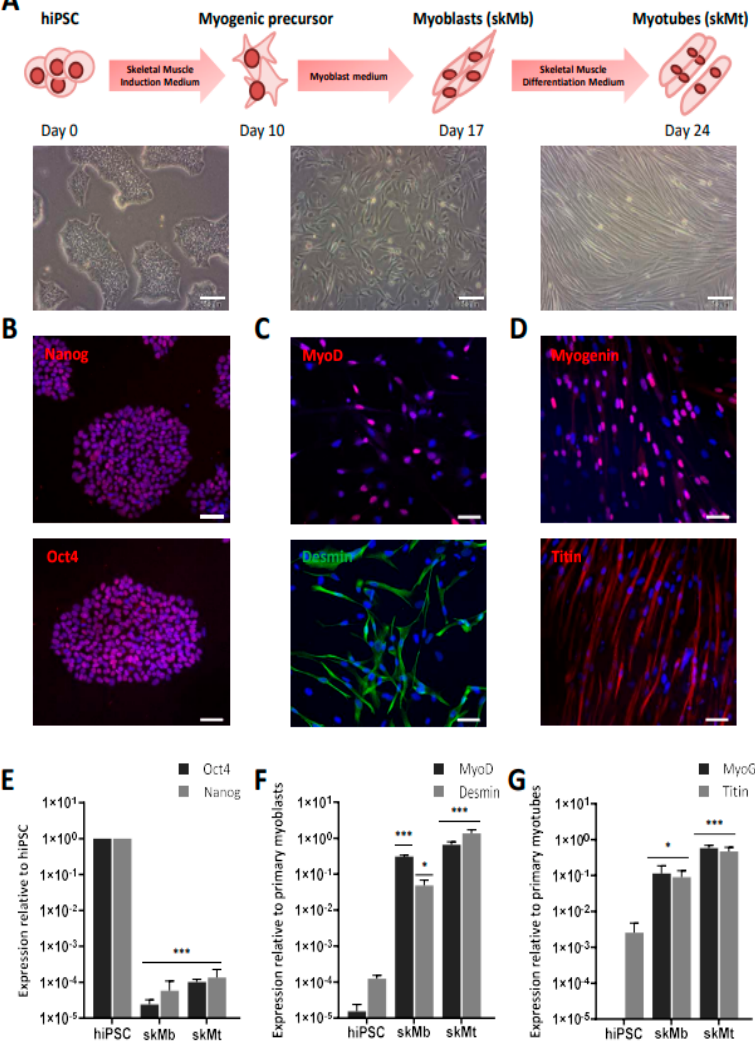
Figure 1. Differentiation of hiPSC into skMC. ( A ) Experimental workflow of skMC differentiation from hiPSC using the Genea Biocells protocol. Representative pictures of hiPSC, skeletal myoblasts (skMb), and myotubes (skMt) with bright field acquisition. Scale bar = 50 µ m. ( B ) Characterization of the expression of pluripotency markers Oct4 and Nanog by immunostaining in hiPSC ( C ) Characteri- zation of the expression of MyoD and desmin by immunostaining in skMb ( D ) Characterization of the expression of MyoG and titin by immunostaining in skMt. Nuclei are labeled by Hoechst staining (blue). Scale bar = 50 µ m. ( E ) Measurement of Oct4 and Nanog expression by qPCR in hiPSC, skMb, and skMt. ( F ) Measurement of MyoD and desmin expression by qPCR in hiPSC, skMb, and skMt. ( G ) Measurement of MyoG and titin expression by qPCR in hiPSC, skMb, and skMt. Gene ex- pression analyses are normalized to hiPSC, primary myoblasts, or primary myotubes. Data are shown as the mean of skMC differentiations of three control cell lines +/ − SD. * 0.01 < p ≤ 0.05 or *** p ≤ 0.005 (Student’s t -test). Abbreviations: hiPSC, human induced pluripotent stem cells; skMb, skeletal myoblasts; skMt, skeletal myotubes; MyoG,